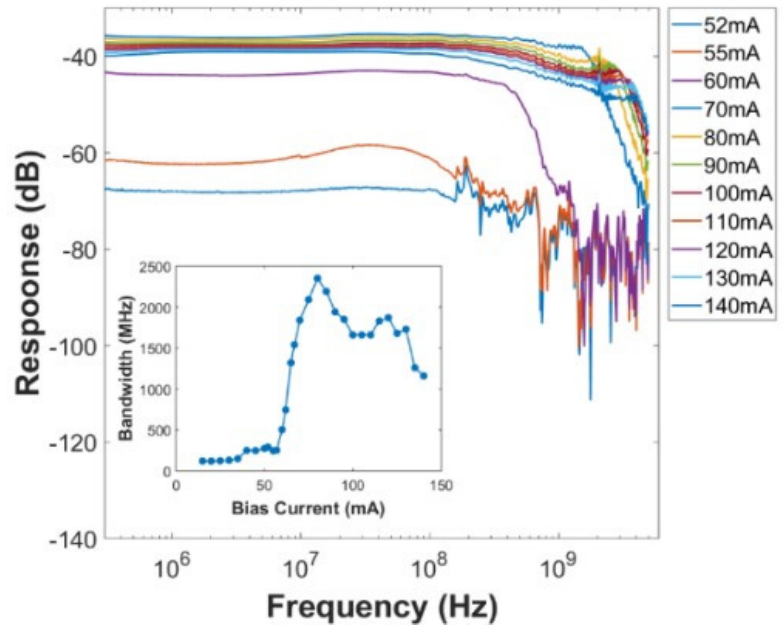
Figure 14. Frequency response of the third-order DFB GaN LD as a function of the drive current and inset of the − 3 dB optical bandwidth as a function of the bias current. Eye diagrams were taken for this device at varying data transmission rates. Error- free transmission was achieved up to 3 Gbit/s and transmission at 2 Gbit/s is shown in Figure 15.